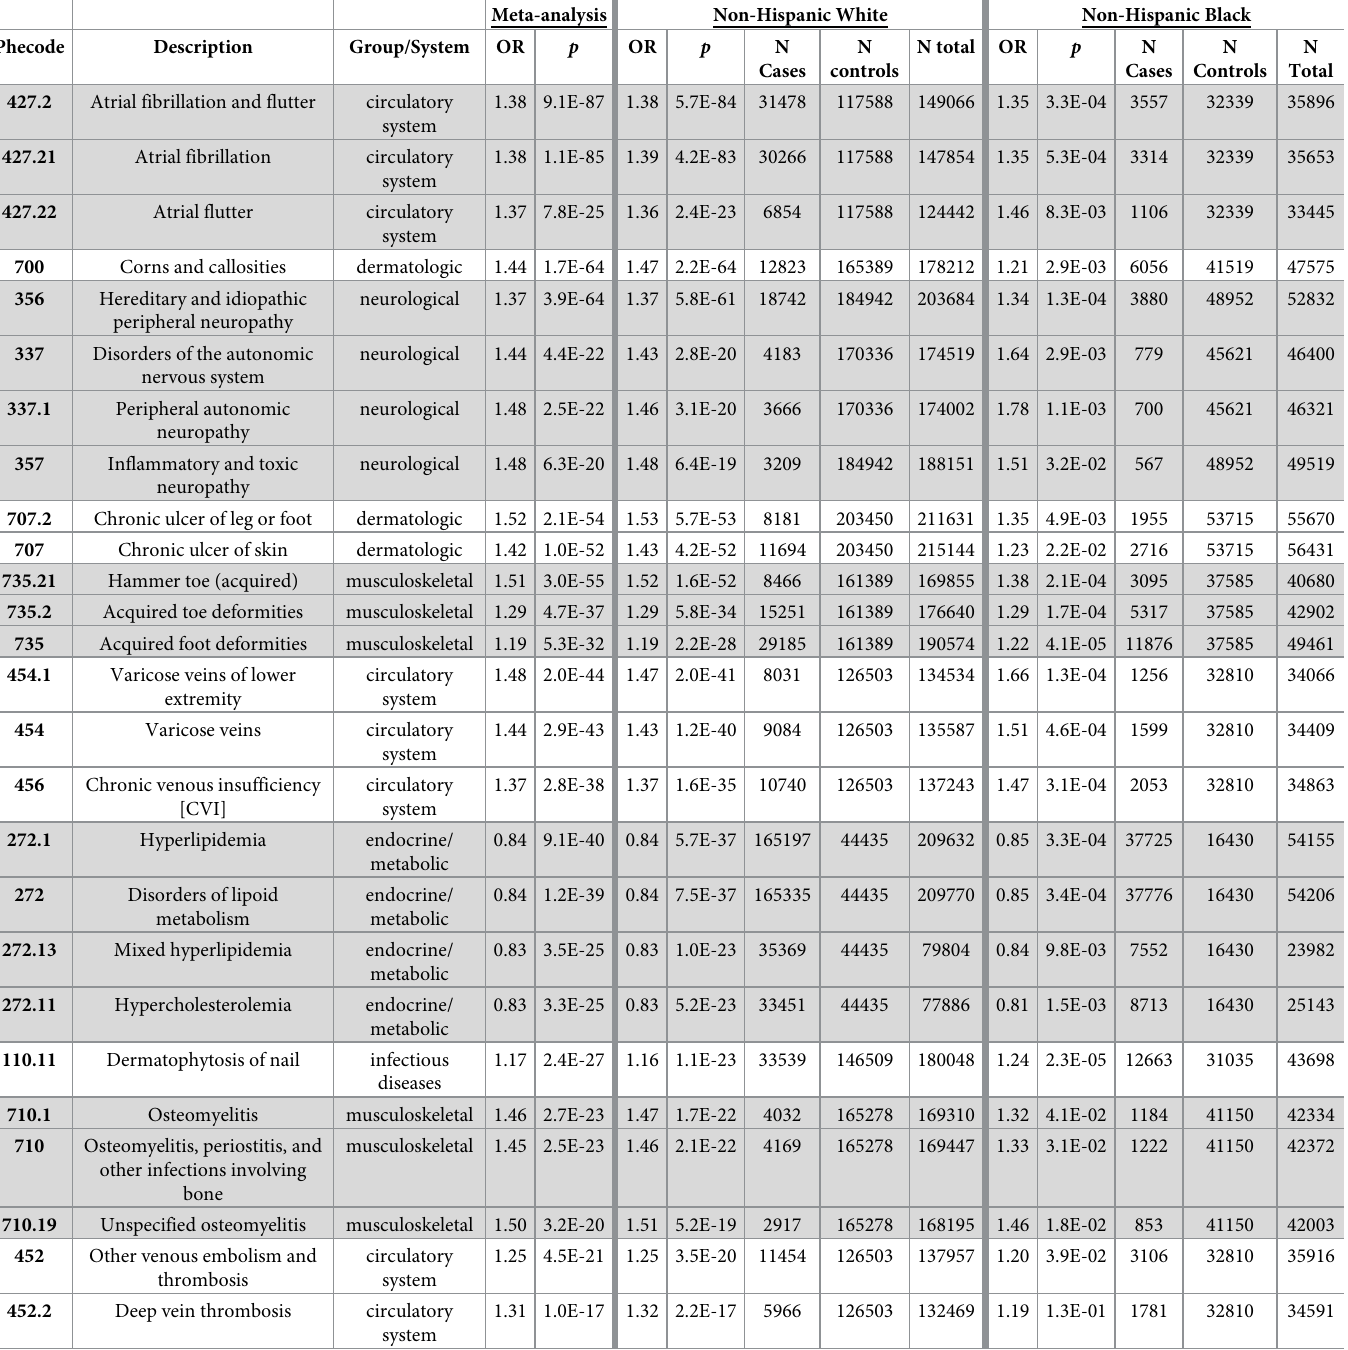
Table 2. Top phenome-wide associations and closely related traits with genetically predicted